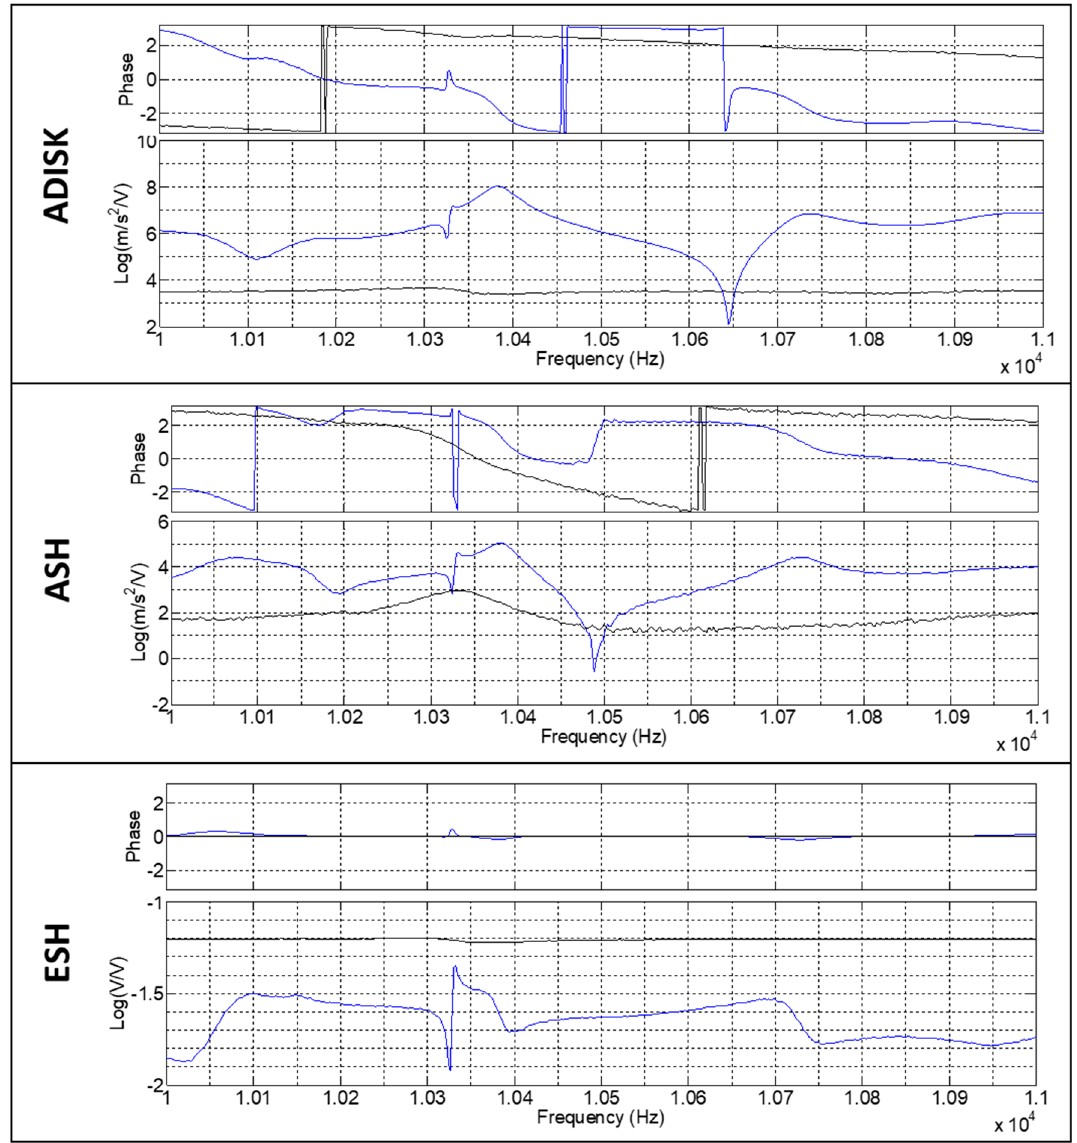
Figure 6. FRF between the sensors in the rotating frame and the PZT for the excitation in the band of 10–11 kHz. The blue line is the “in air” configuration, and the black line is the “in water” configuration. Rotating case ( f f = 4.1 Hz).